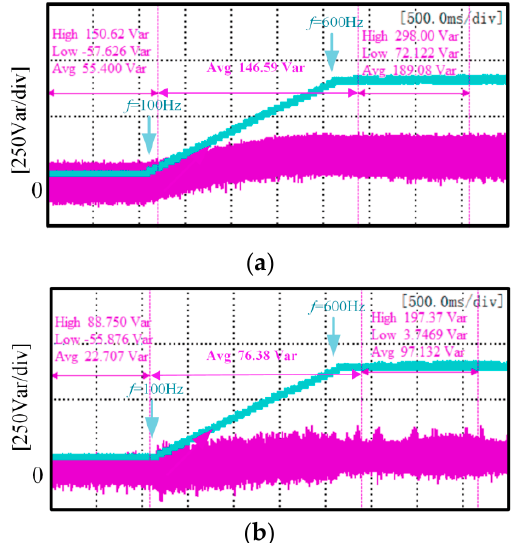
Figure 13. Dynamic performance under supply frequency changes: ( a ) Frequency variation and reactive power of conventional control schemes; ( b ) Improved control scheme frequency variation and reactive power.